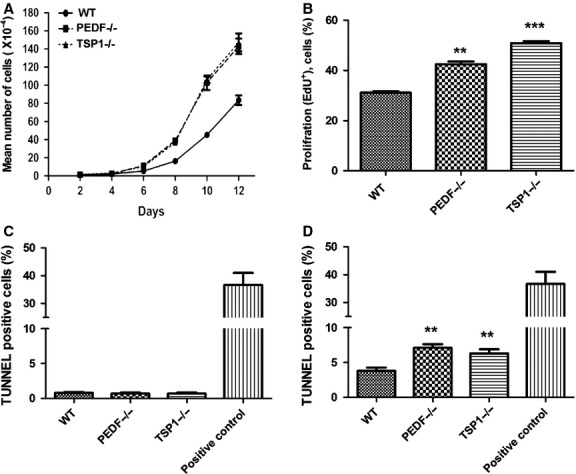
Alterations in proliferation and apoptosis of RPE cells. (A) The rate of proliferation was determined by counting the number of cells. A significant increase in the proliferation of PEDF−/− and TSP1−/− RPE cells was observed compared with WT cells. (B) An increase in the rate of DNA synthesis was observed in TSP1−/− and PEDF−/− RPE cells compared with the WT cells. (C) The rate of apoptosis was determined using TdT‐ dUTP Terminal Nick‐ End Labeling (TUNNEL). A similar experiment was carried out using H2O2 (50 μΜ), as an inducer of apoptosis (positive control). Please note no differences were observed in the basal rate of apoptosis in these cells. (D) A significant increase in the rate of apoptosis was observed in PEDF−/− and TSP1−/− RPE cells when challenged with H2O2 (50 μΜ) compared with WT cells (0.05, **P < 0.01, ***P < 0.001, n = 3).